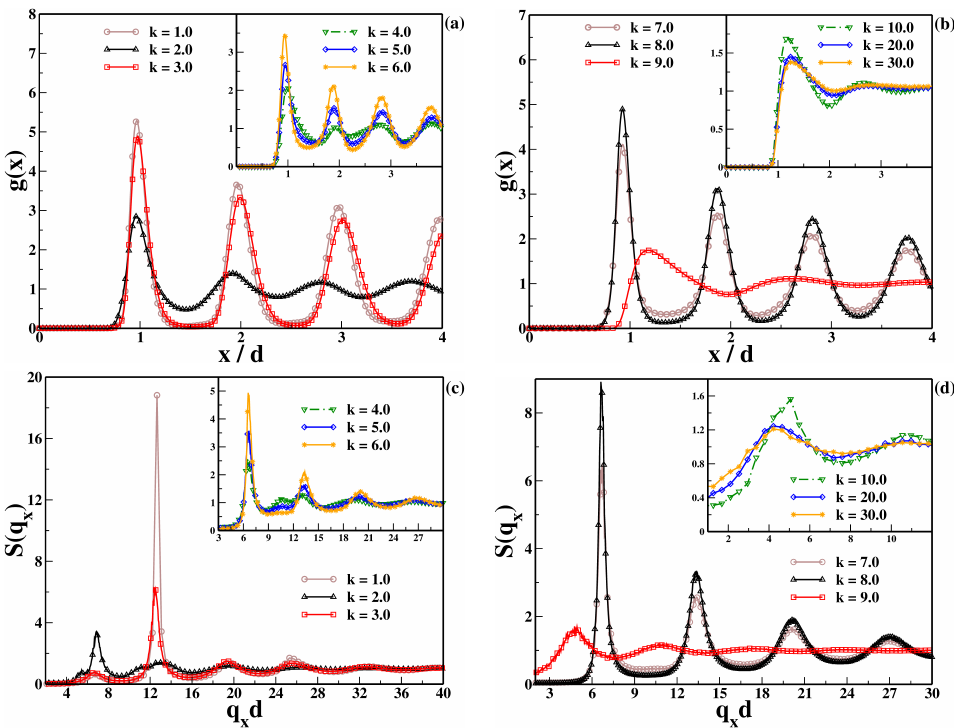
Figure 6. ( a , b ) Pair distribution functions and ( c , d ) static structure factors along the x - direction for several values of the stiffness parameter, 1 ≤ k ≤